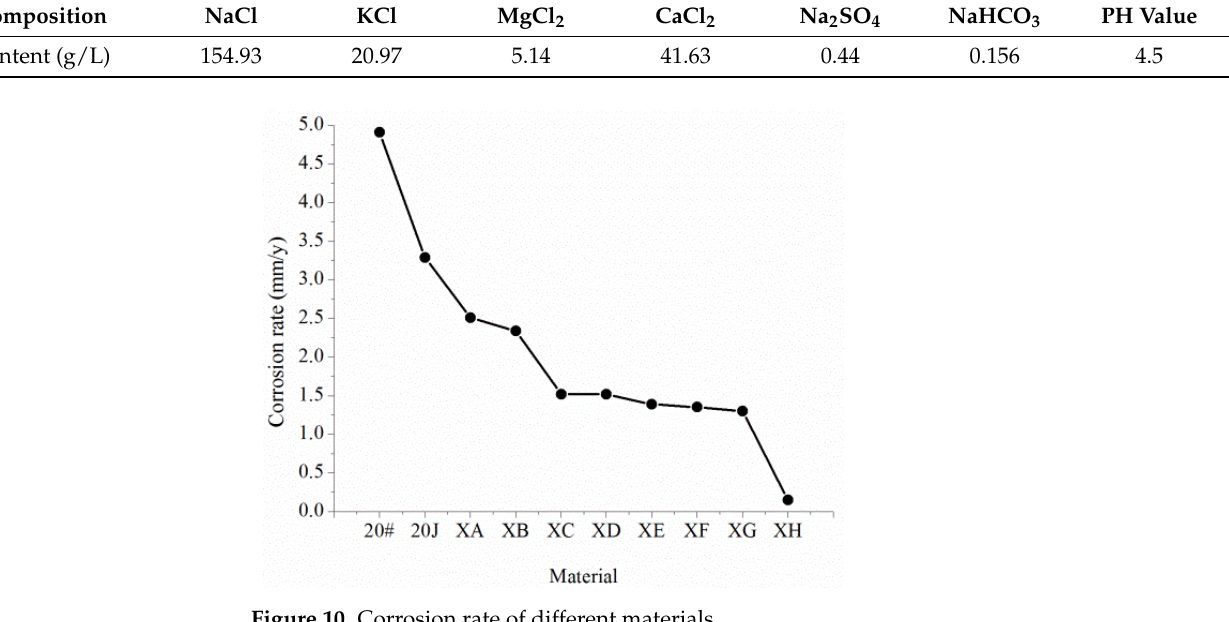
Table 13. Formulation of simulated solution.